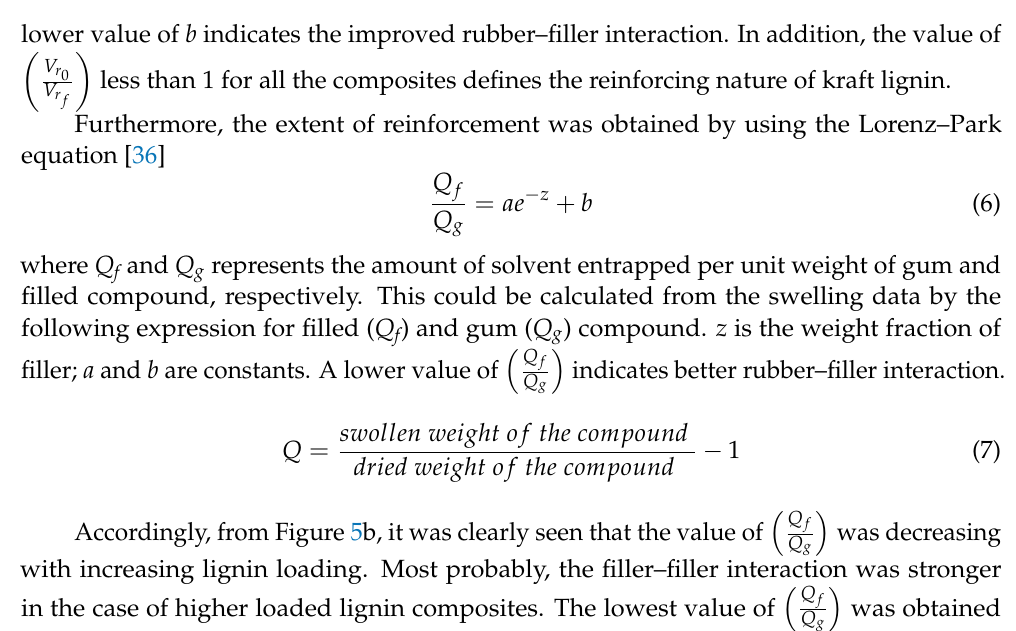
Figure 5. ( a ) Effect of lignin content on the volume fraction of rubber ( V rf ), ( b ) variation of with e − z (Cunneen–Russel plot) and variation of density (obtained from equilibrium swelling experiment), ( d ) swelling index of the BR gum and BR/kraft lignin (KL)/TESPT